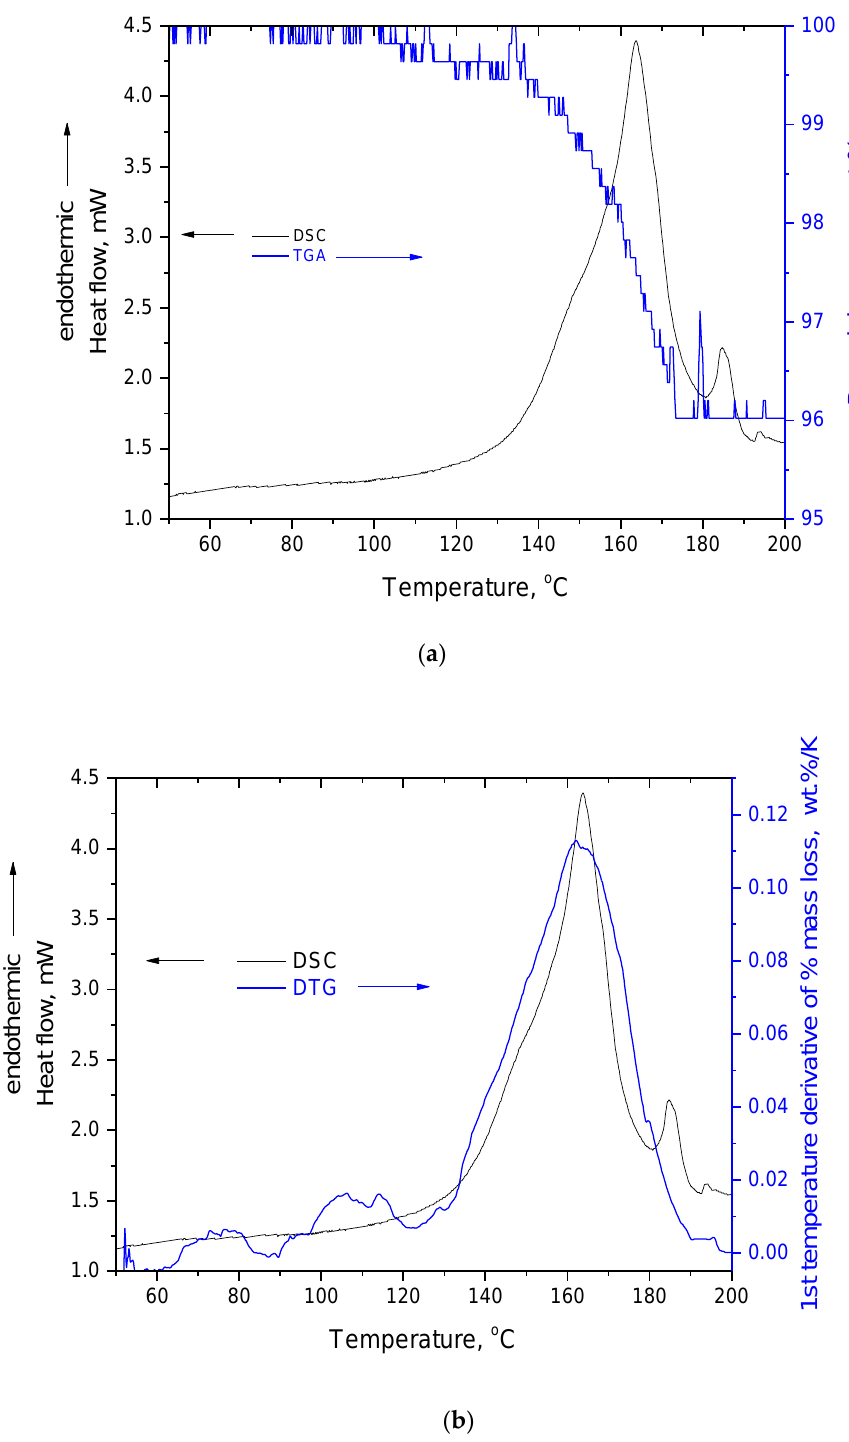
Figure 2. ( a ) DSC and TGA curves of silybin and ( b ) DSC and DTG (first temperature derivative of % mass loss) curves of silybin.